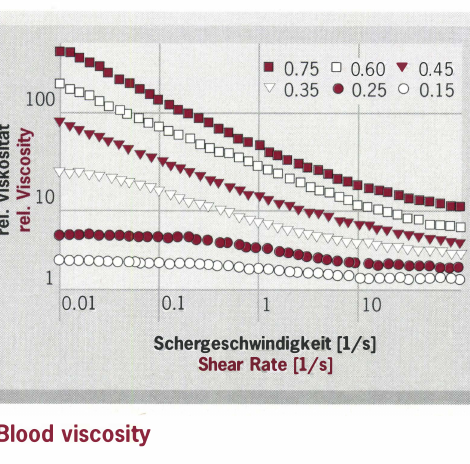
Abb. 3: Fliellkurven fiir eine Gruppe gesunder Probanden (MW 0 ± s.d.}, fiir einen Patienten mit Hyperviskosi· tiitssyndrom O sowie einen Aniimiker • Fig. 3: Flow curves for a group of healthy persons (MW 0 ± s.d.}, for a patient with hyperviscosity syndrome o and an anaemic patient •